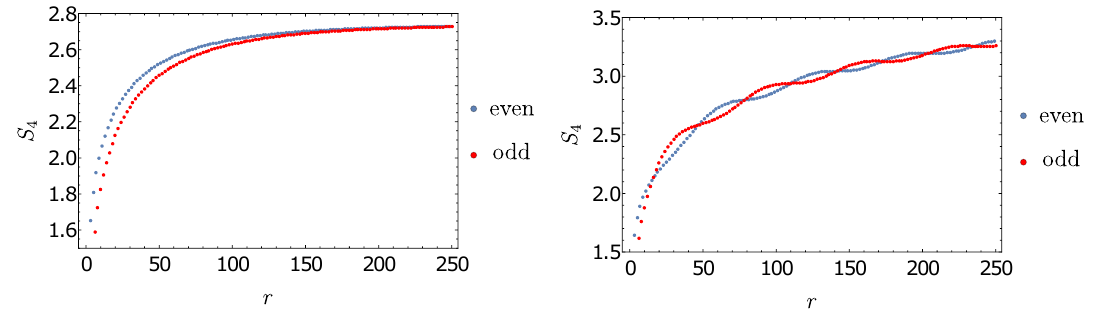
Figure 11 . Left panel: S 4 for m = 1 / 200 and k F = 0 , distinguishing the parity ( − 1) n of r . Both branches coincide when r (cid:29) 1 . Right panel: S 4 for m = 1 / 200 and k F = 1 / 20 ; the even and odd branches are shifted by π/ 2 k F as a function of r